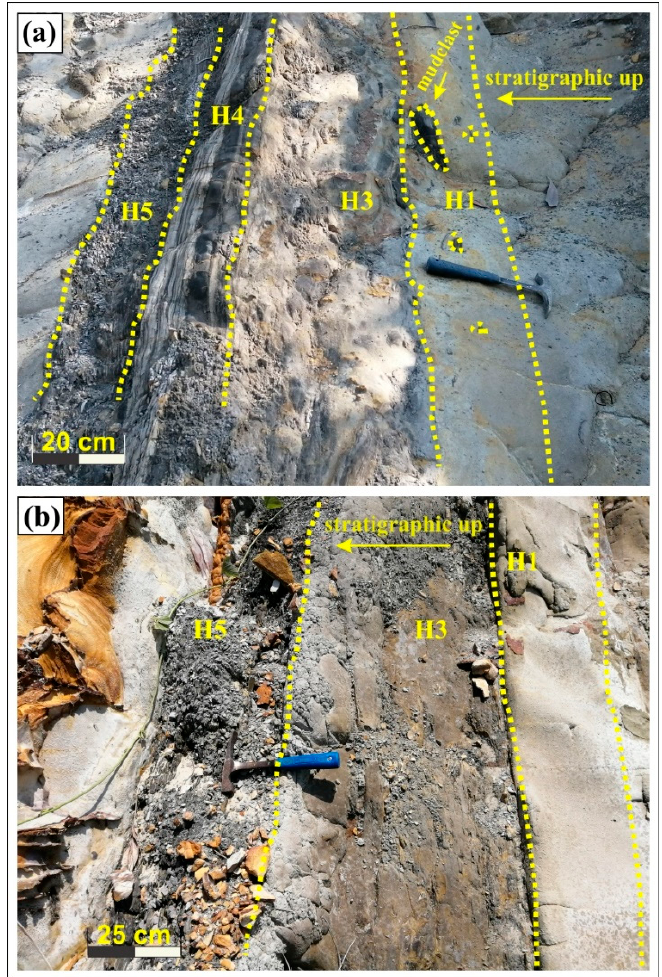
Figure 7. Hybrid event beds interpreted in a distal lobe system. ( a ) Distal lobe contains more vertical thickness of muddy hybrid event bed facies (H3, H4, and H5) than the proximal and medial lobes moving from the base to the top of sequence in the Lapasan (LPS) section, NW Sabah. ( b ) The most distal part of the lobe contains the minimum or least vertical thickness of sandy hybrid facies (H1 or H2) where the facies are mainly composed of chaotic intervals of H3, and mud facies of H5 in the Lok Kawi wildlife (LKW) section, SW Sabah.